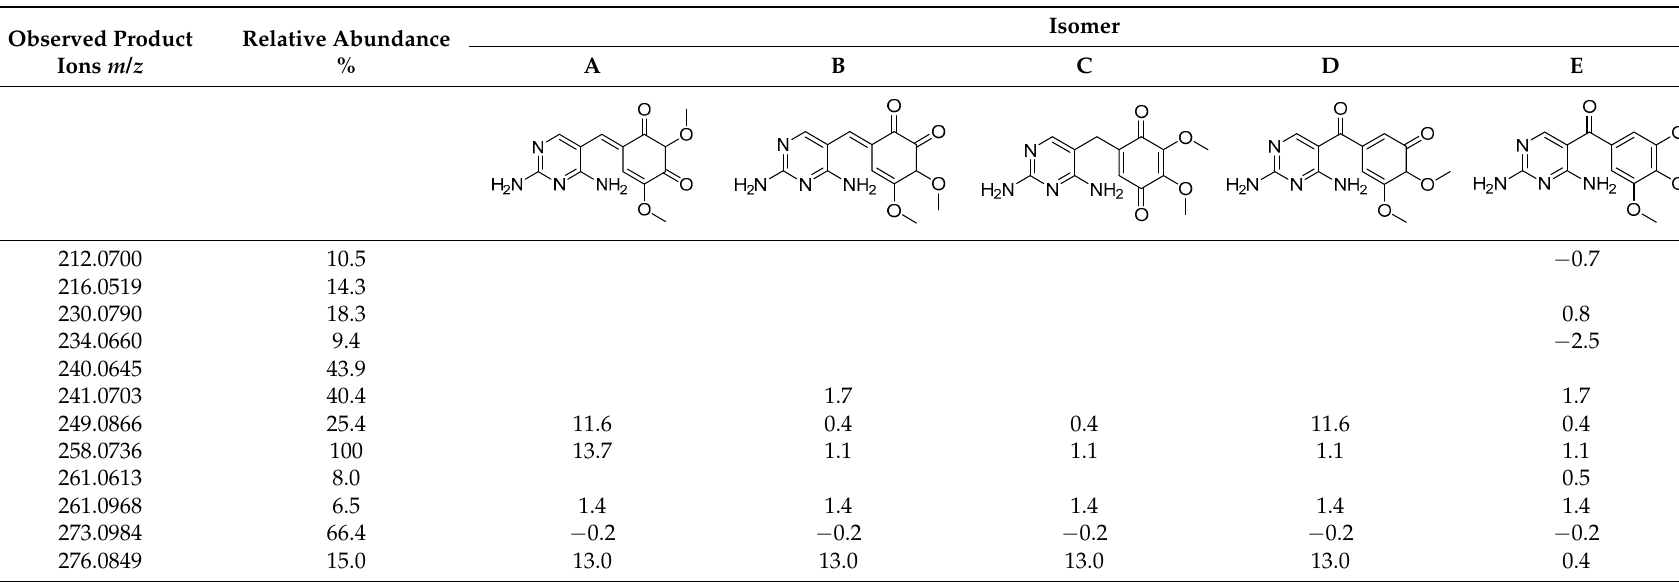
Table 2. Mass accuracy of the product ions of the five proposed structures for OP290 according to in-silico fragmentation analysis done by Mass Frontier software. Observed Product Relative Abundance Ions m / z